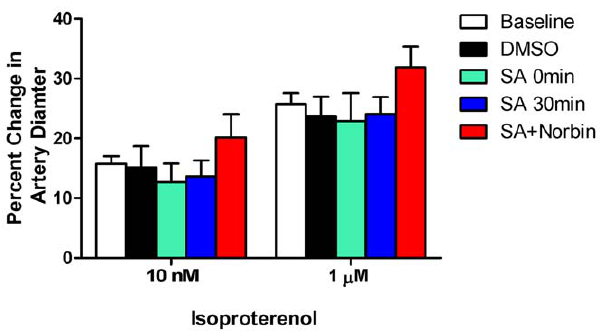
Figure 3. Isoproterenol induced artery dilation was indepen- dent of KOR or ERK signaling. Effects of isoproterenol (10 nM, 1 m M) on pial artery diameter before (baseline) and after HI did not change significantly in the presence and absence of various interven- tions, compared to baseline p . 0.05. N=5 in each group. Percentage change= (diameter after isoproterenol 2 diameter before